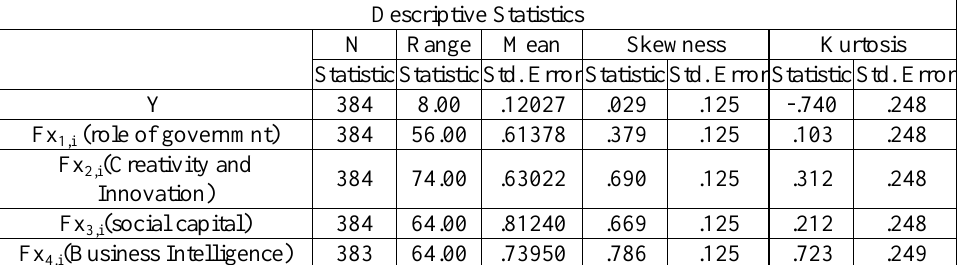
Table. 3. Descriptive Test of Research Variables